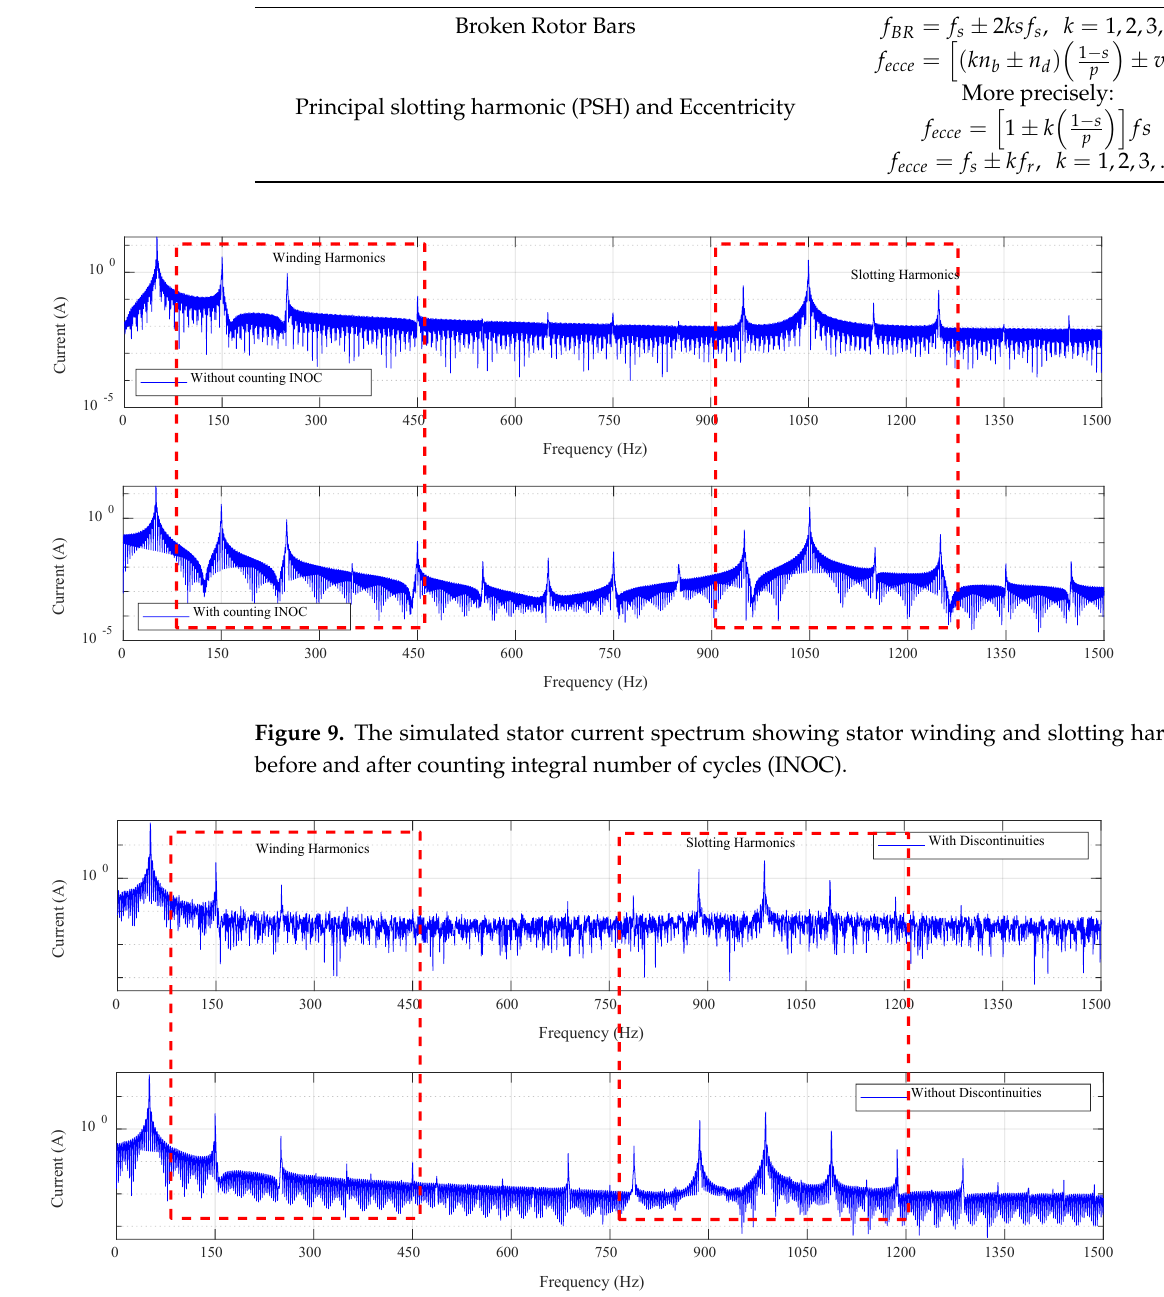
Figure 10. The effect of signal discontinuities on the spectrum resolution.